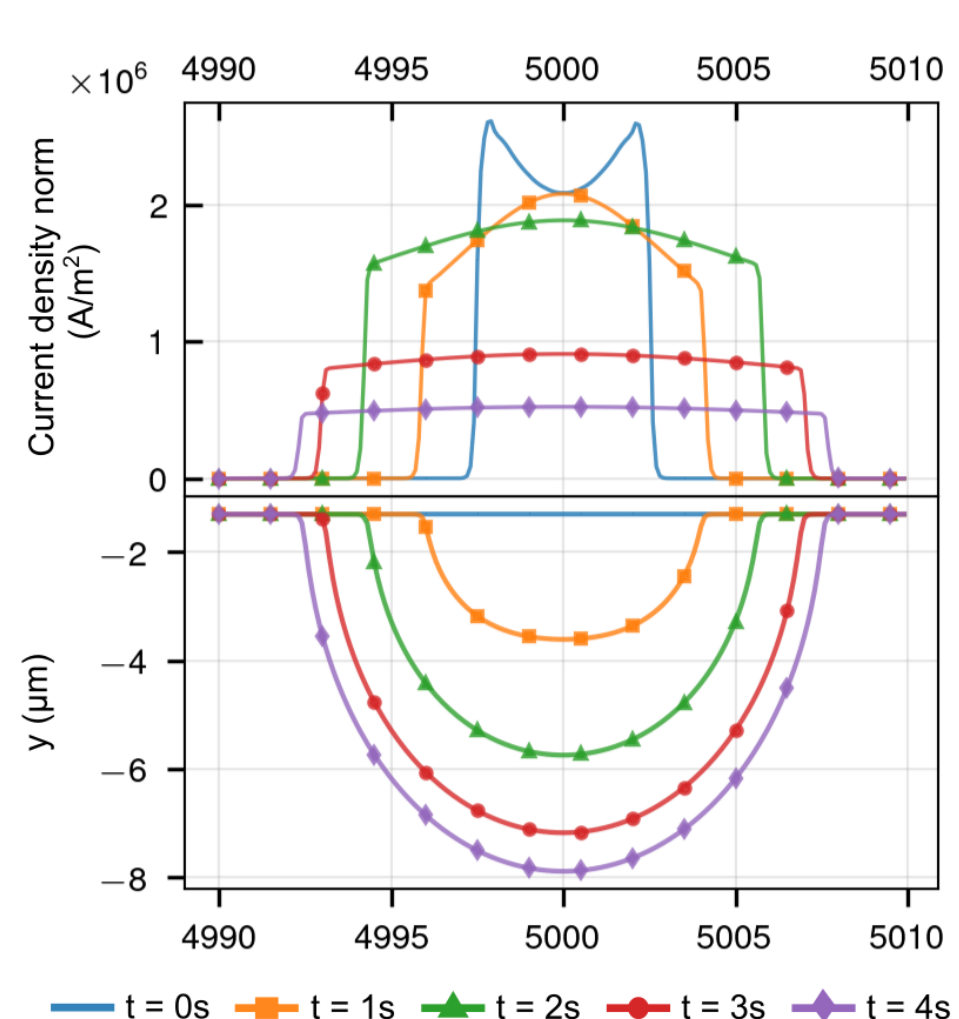
Figure 2. The profile evolution and corresponding current density norm on the reaction interface. Later in the process, the distribution is inverted, the current density is then always higher in the center than that in the boundary. This will lead to a concave-like profile, i.e., a micro